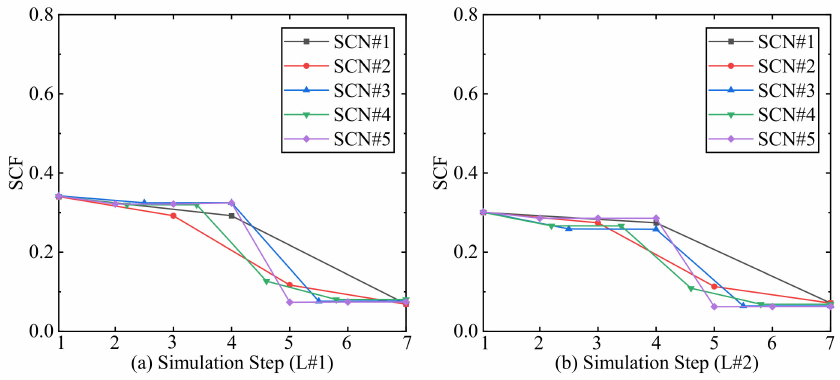
Figure 7. SCF of sidewall middle of level #1 and level #2.